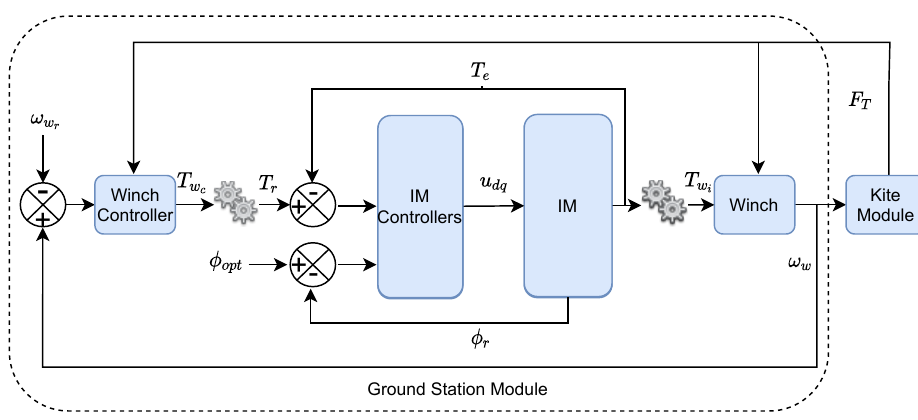
Figure 1. Two-loop control strategy for the